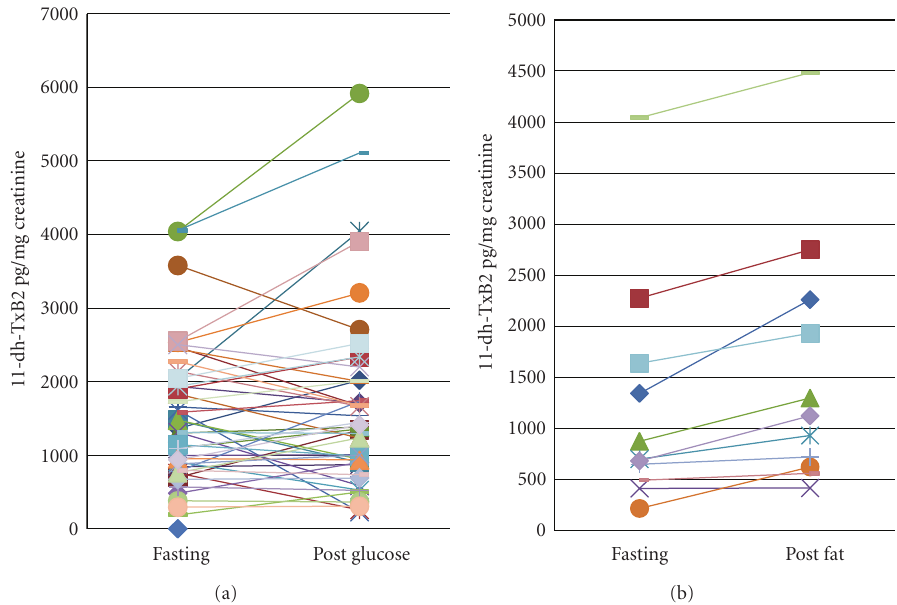
Figure 1: The response of urine thromboxane after glucose or fat ingestion (a). Urine thromboxane response to glucose ingestion ( n = 49) (b). Urine thromboxane response to fat ingestion ( n = 11). A more consistent increase in 11-dh-TxB2 was observed following the fat challenge compared to the glucose challenge. 11-dh-TxB2 =